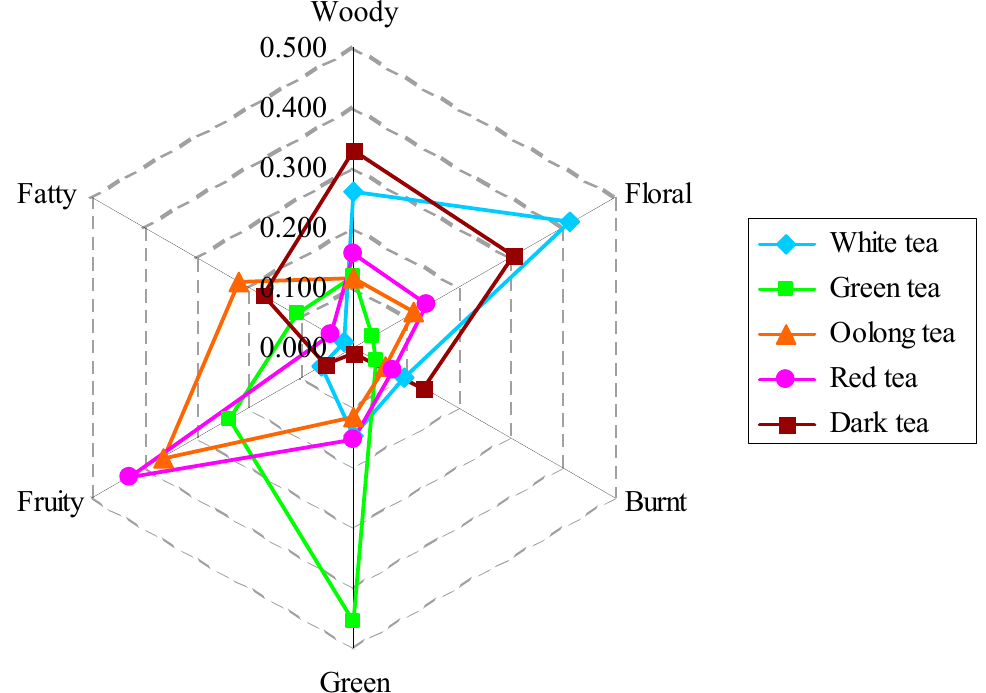
Figure 1. Radar chart of index of odor I(o) in tea with different types.